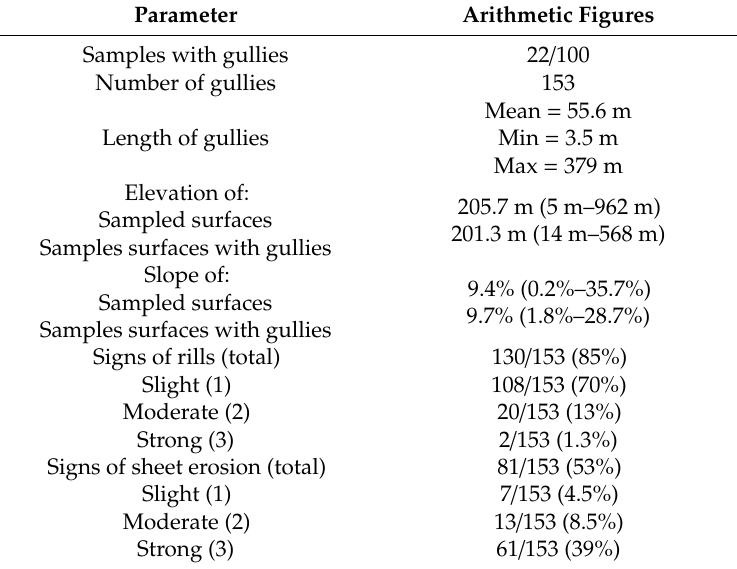
Table 1. A summary of the